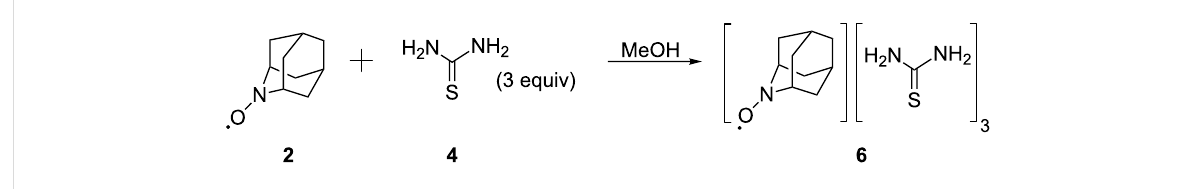
1:3 in this case as elucidated by elemental analysis, while that of bromoadamantane and 4 was reported to be 1:4 [9].